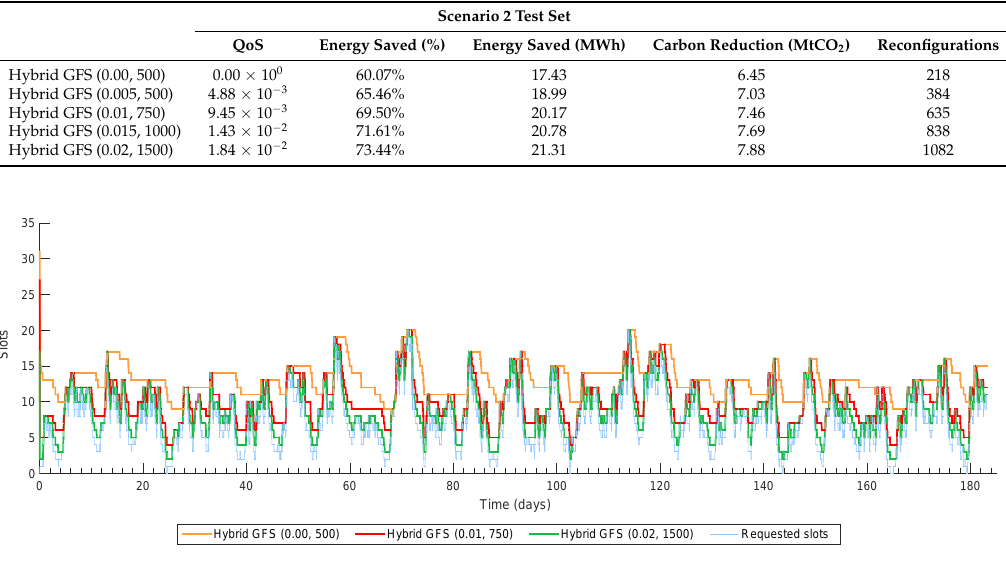
Figure 5. Cluster simulation trace for the test set of scenario